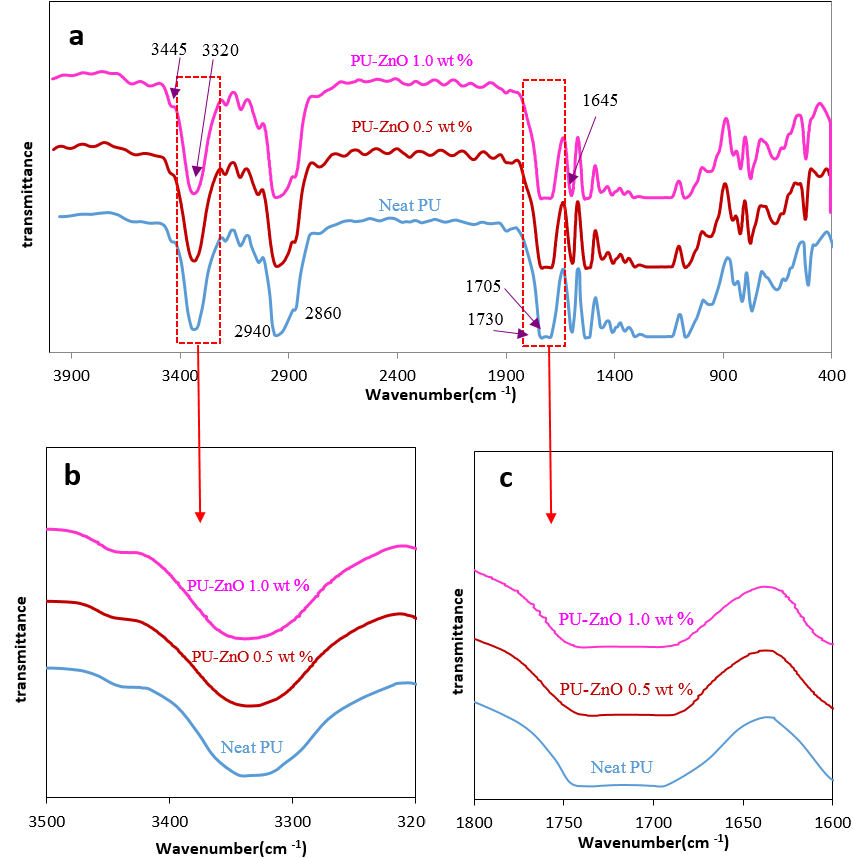
Figure 1. IR analysis ( a ) IR analysis of PU ‐ ZnO MMMs; ( b ) NH segment; ( c ) C=O segment.